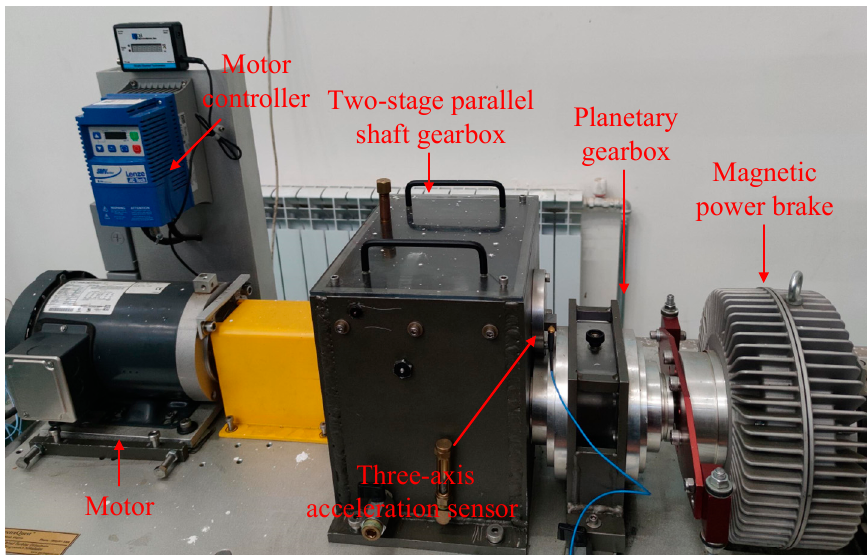
Figure 8. Wind turbine drive system fault diagnosis test bench.